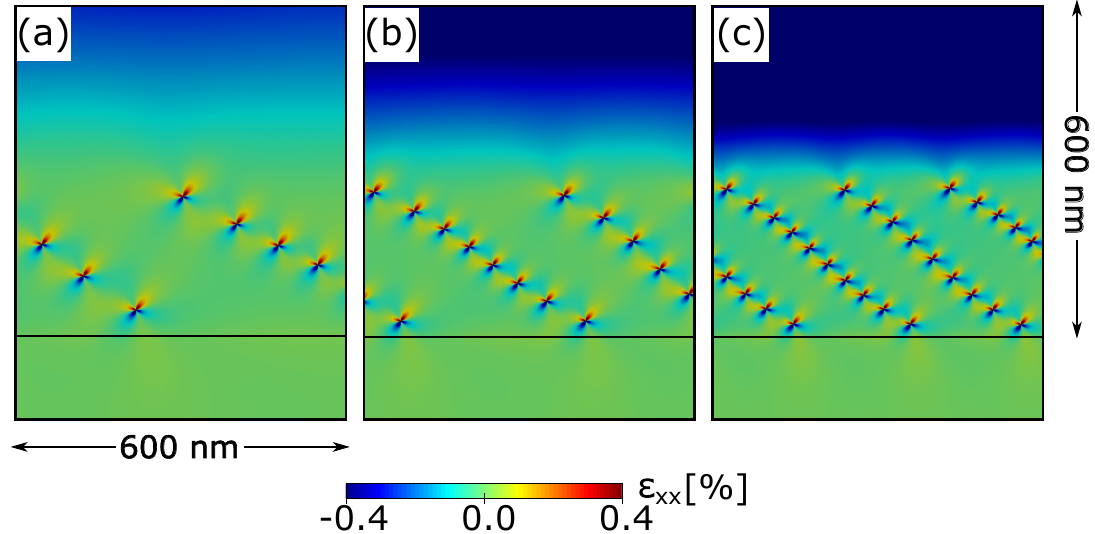
Figure 5. Comparison between different grading rates of 20.83% µ m − 1 ( a ), 41.67% µ m − 1 ( b ), and 83.33% µ m − 1 ( c ). Respective final concentrations of Ge are 12.5%, 25%, and 50%. Ratios between dislocation number in the unit cell and grading rate have been kept fixed. Colormaps show the values of ε xx component of the strain